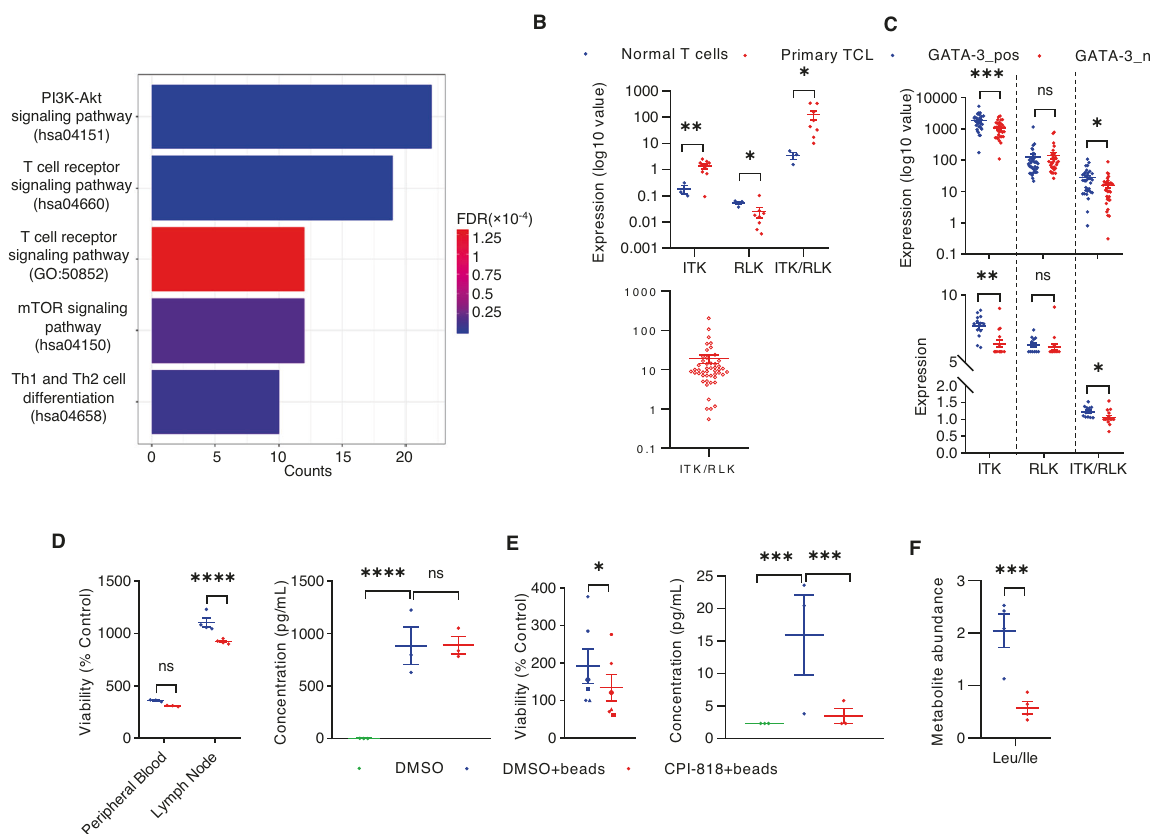
Fig. 4 ITK is a therapeutic vulnerability. A Signaling pathways enriched with GATA-3 dependent kinases ( n = 207) are shown. B ITK and RLK expression was determined in normal and malignant T cells (at top). The ITK/RLK ratio is also calculated and shown in an independent Nanostring dataset (at bottom). C ITK and RLK expression from CTCL (at top) and T-ALL (at bottom) biopsy specimens are summarized and strati fi ed by GATA-3 expression as determined by immunohistochemistry. D , E Cell viability (left) and IL-10 production (right) are evaluated in normal T cells ( D ) and malignant T cells ( E ) isolated from peripheral blood. T cells were treated with anti-CD3/CD28 beads and CPI-818 (1 μ M), or vehicle control (DMSO), as indicated. F Leucine/isoleucine abundance was quanti fi ed by mass spectrometry in similarly treated malignant T cells. Data are represented as mean ± s.e.m. (standard error of the mean). * p < 0.05, ** p < 0.01, *** p < 0.001, **** p <